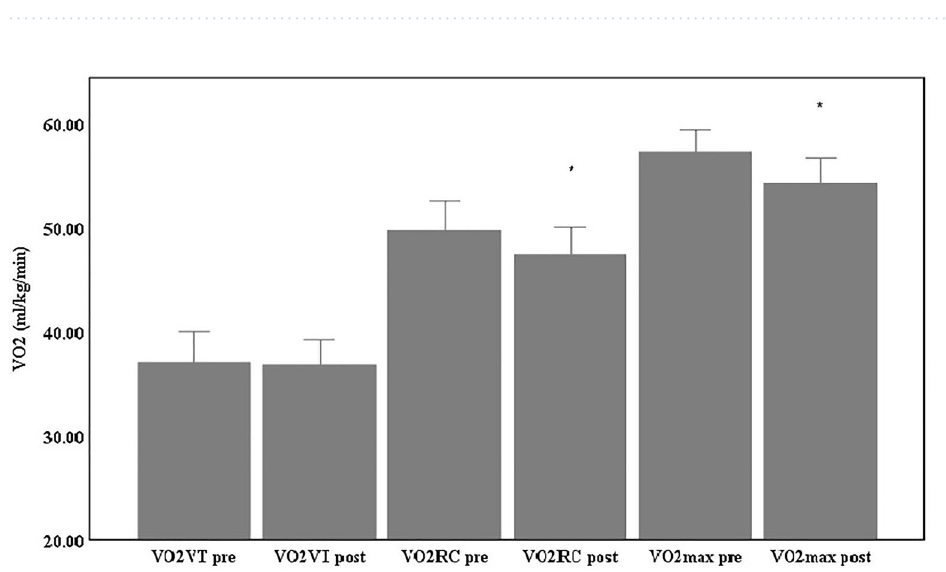
Figure 1. VO 2max , VO 2VT and VO 2RC pre- and post-COVID-19.